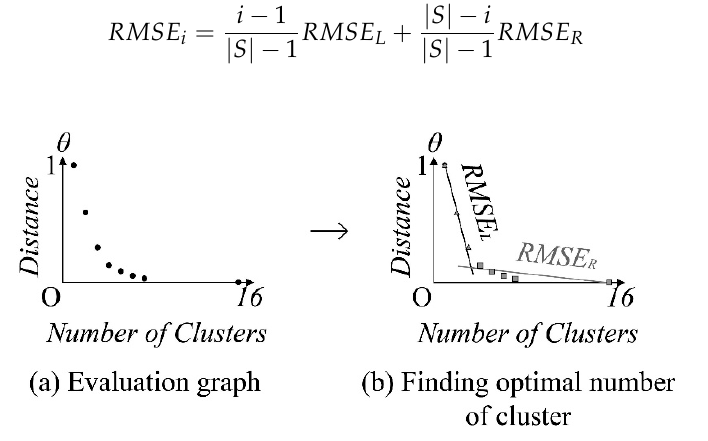
Figure 7. Working process of LMethod.